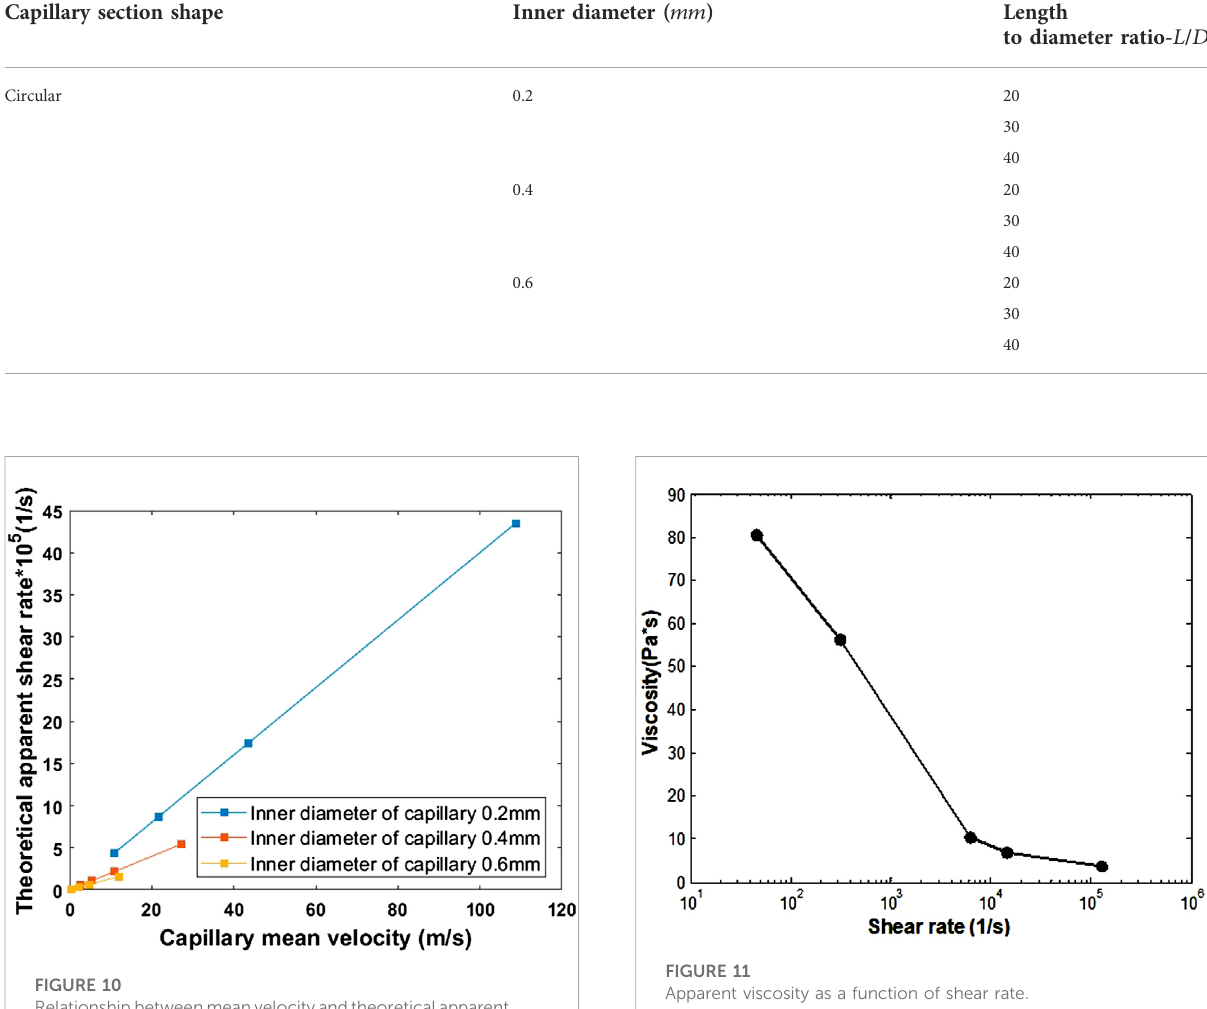
Relationshipbetweenmeanvelocityandtheoreticalapparent shear rate of capillary tubes with different inner